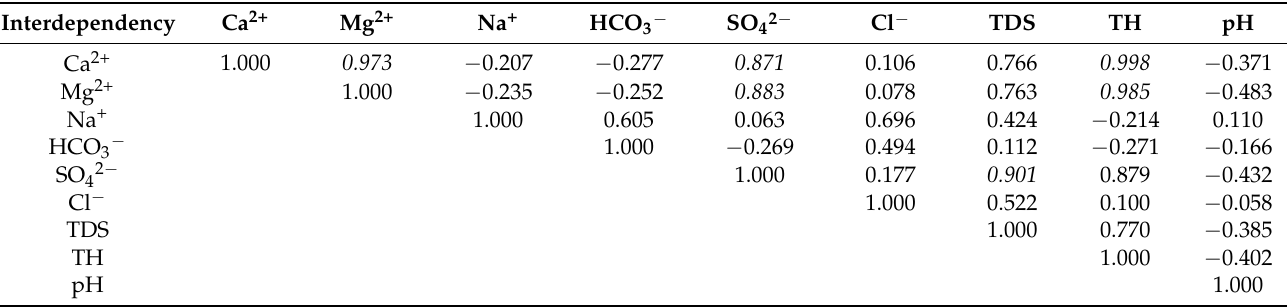
Table 4. General Element